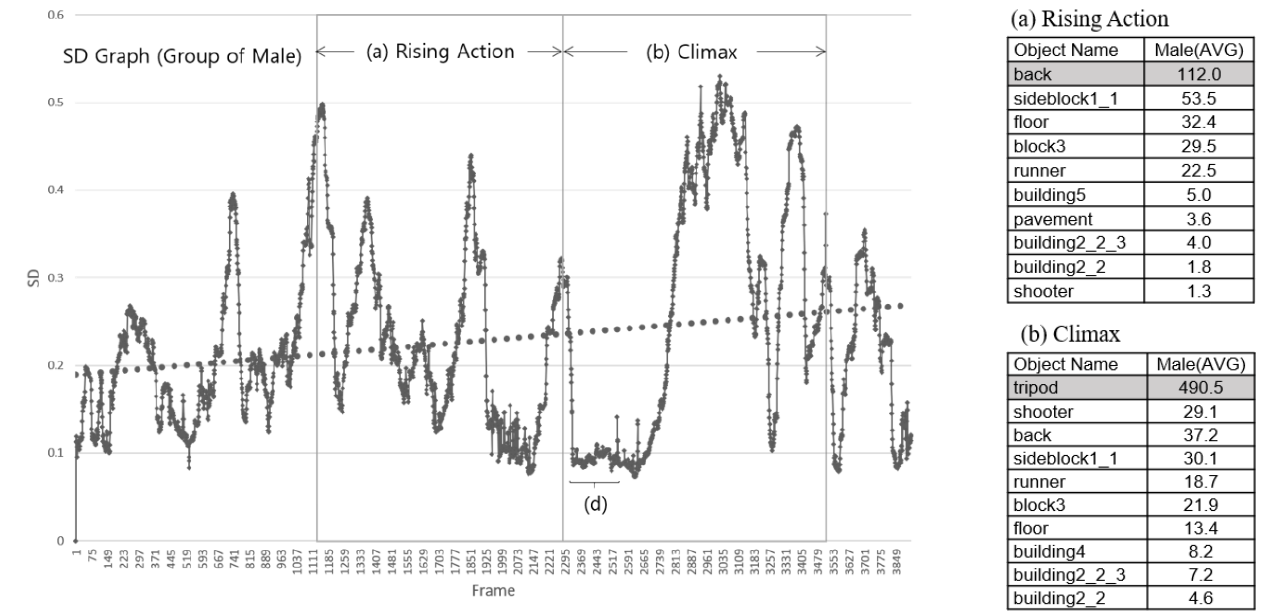
Figure 8. Male Group in the Rising Action and Climax (Standard Deviation ( left ) and Objects Most Seen ( right )).